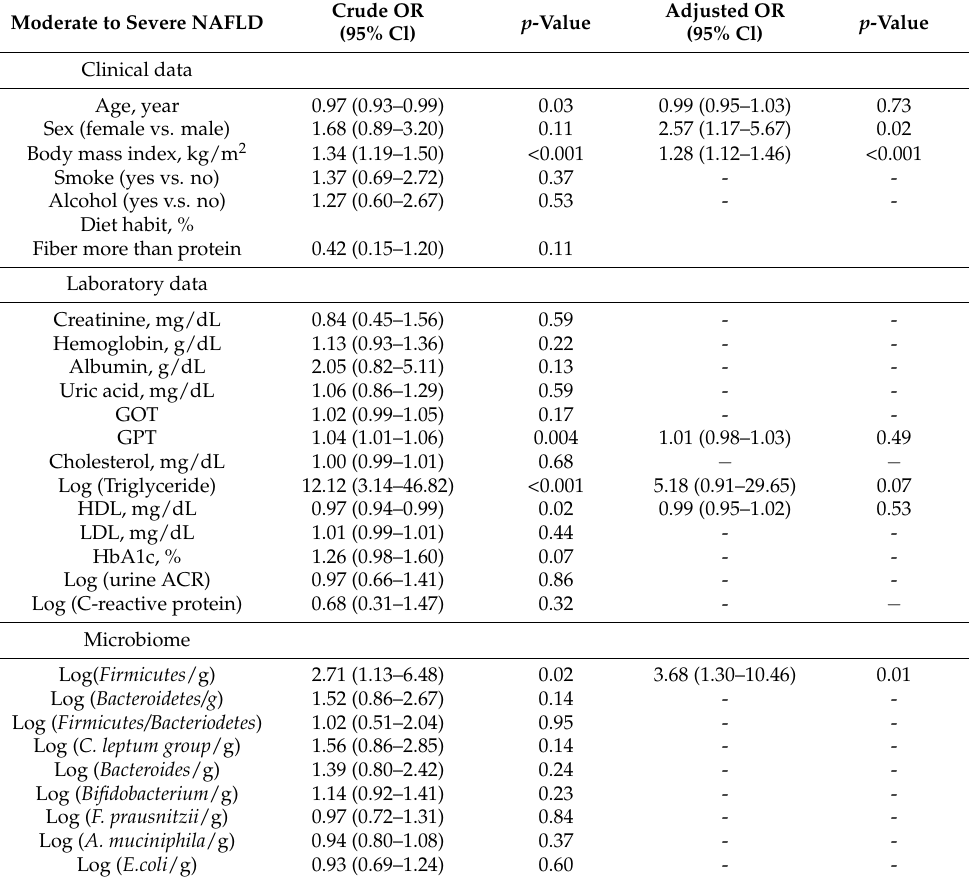
Table 3. Logistic regression of determinants of the severity of